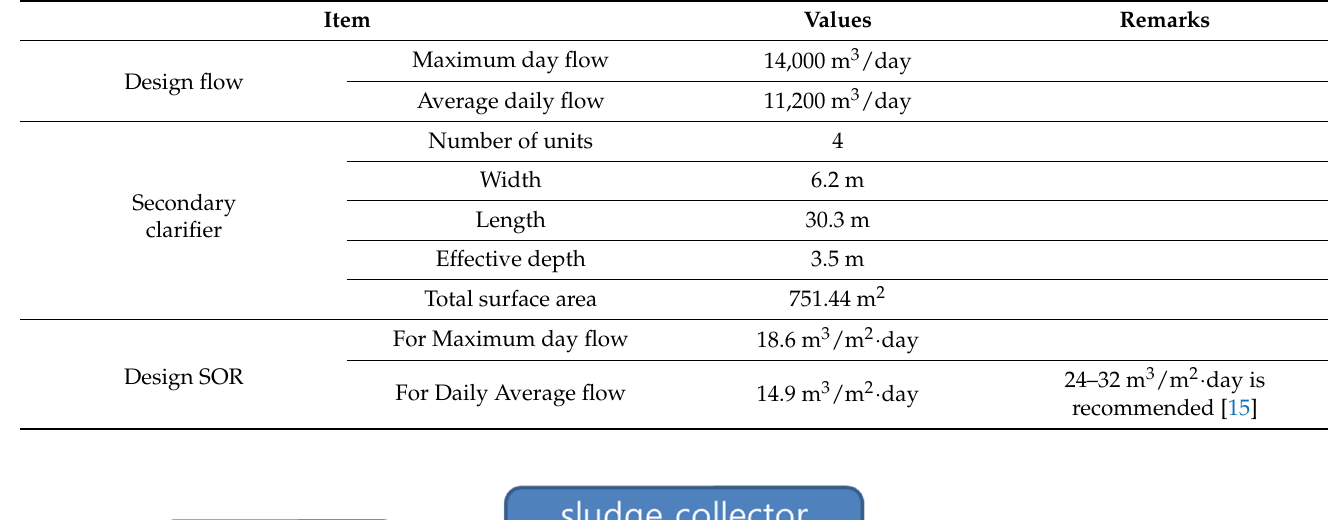
Table 2. Design specifications of the Gould Type I secondary clarifier at plant B.